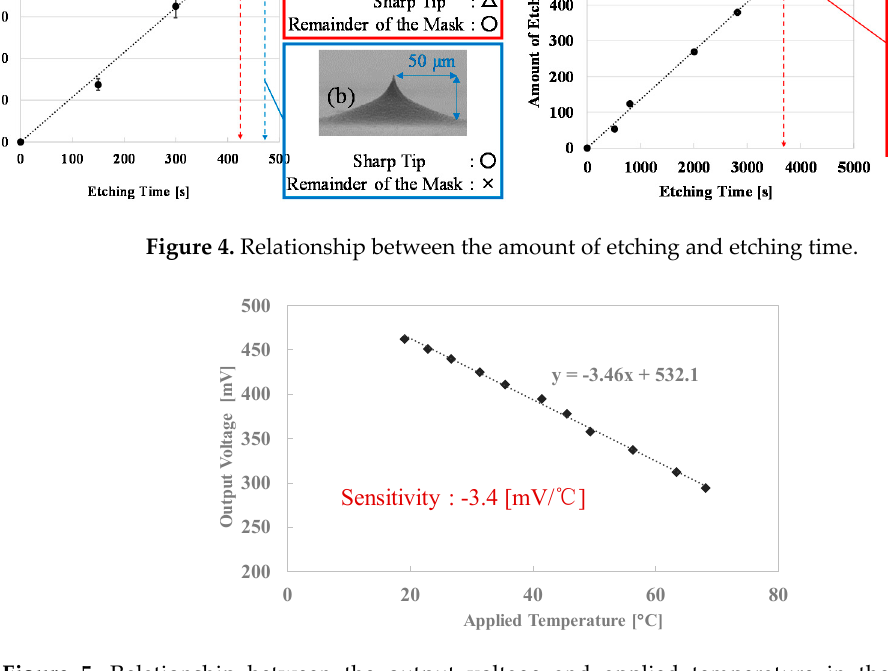
Figure 5. Relationship between the output voltage and applied temperature in the fabricated temperature sensor.